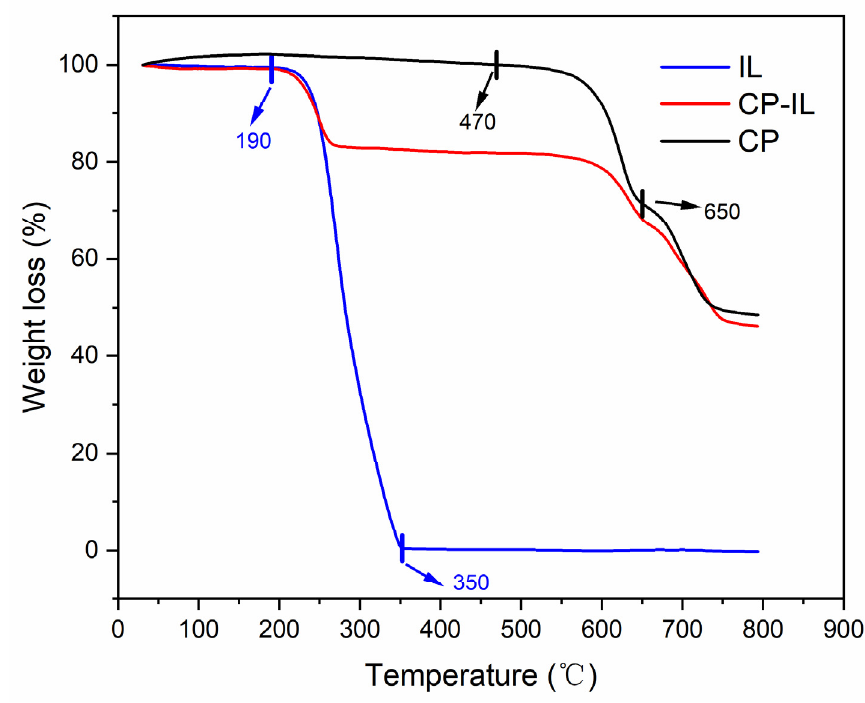
Figure 6. Thermogravimetric analysis (TGA) of CP, CP-IL, and